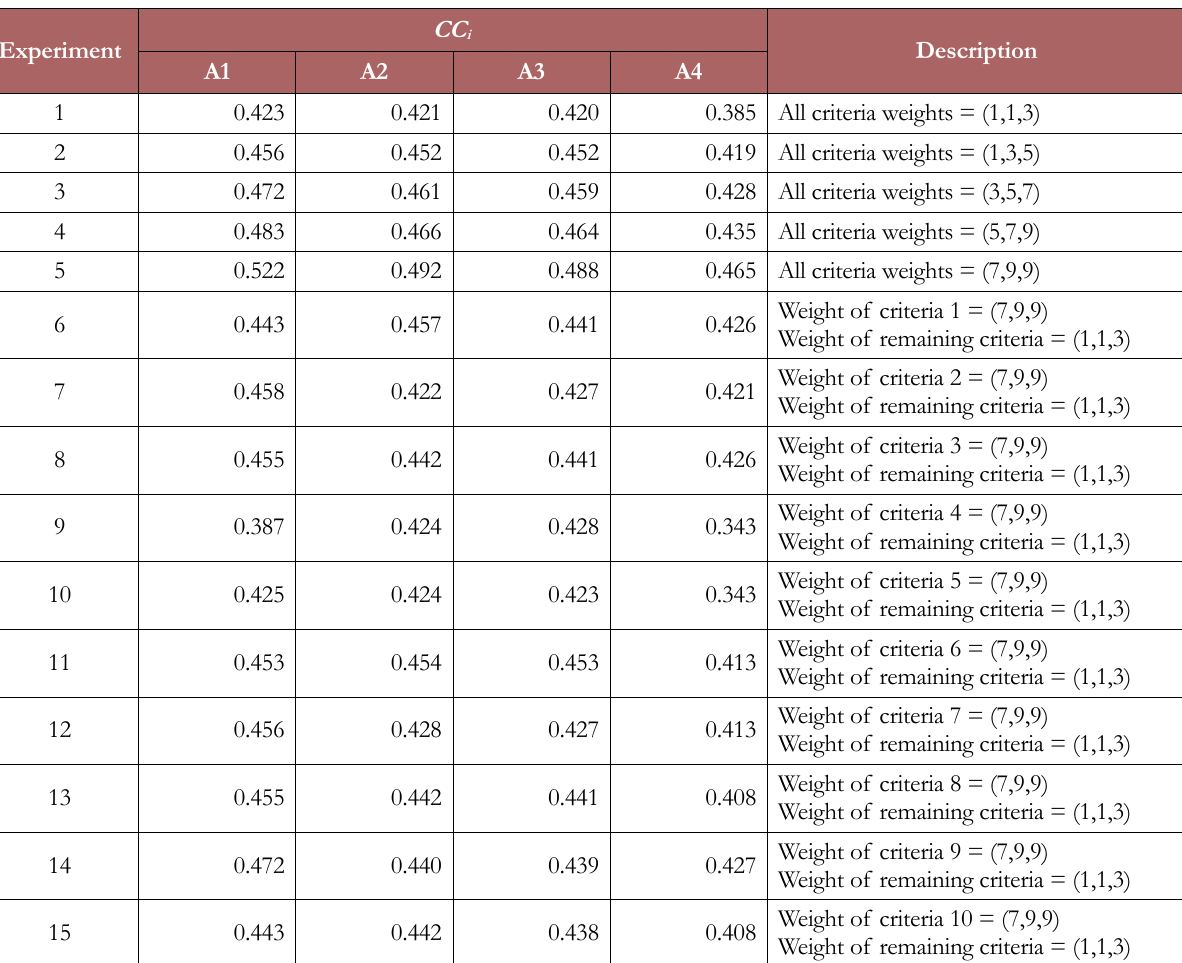
Table 14. Results of sensitivity analysis